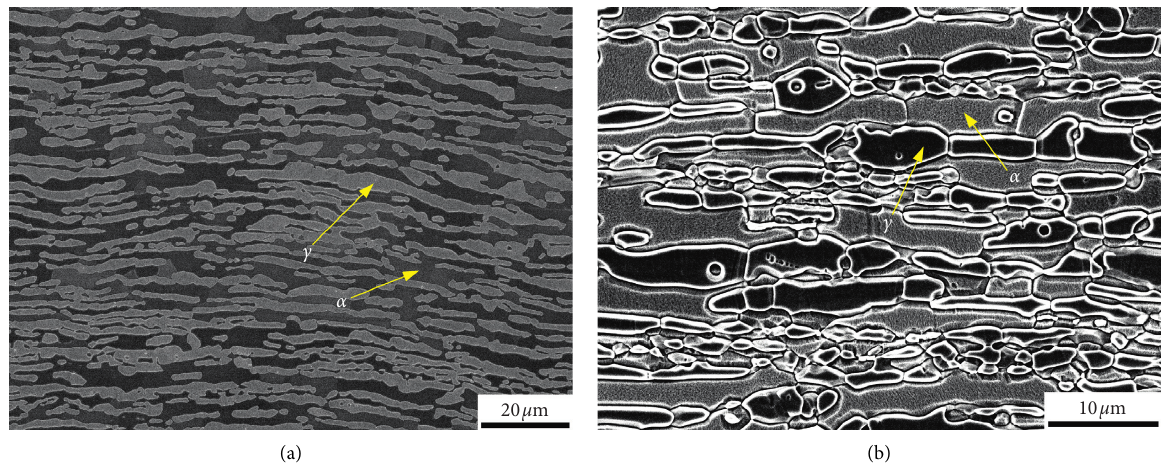
Figure 7: The SEM images of BM: (a) electroetched with KOH solution; (b) electroetched with oxalic acid